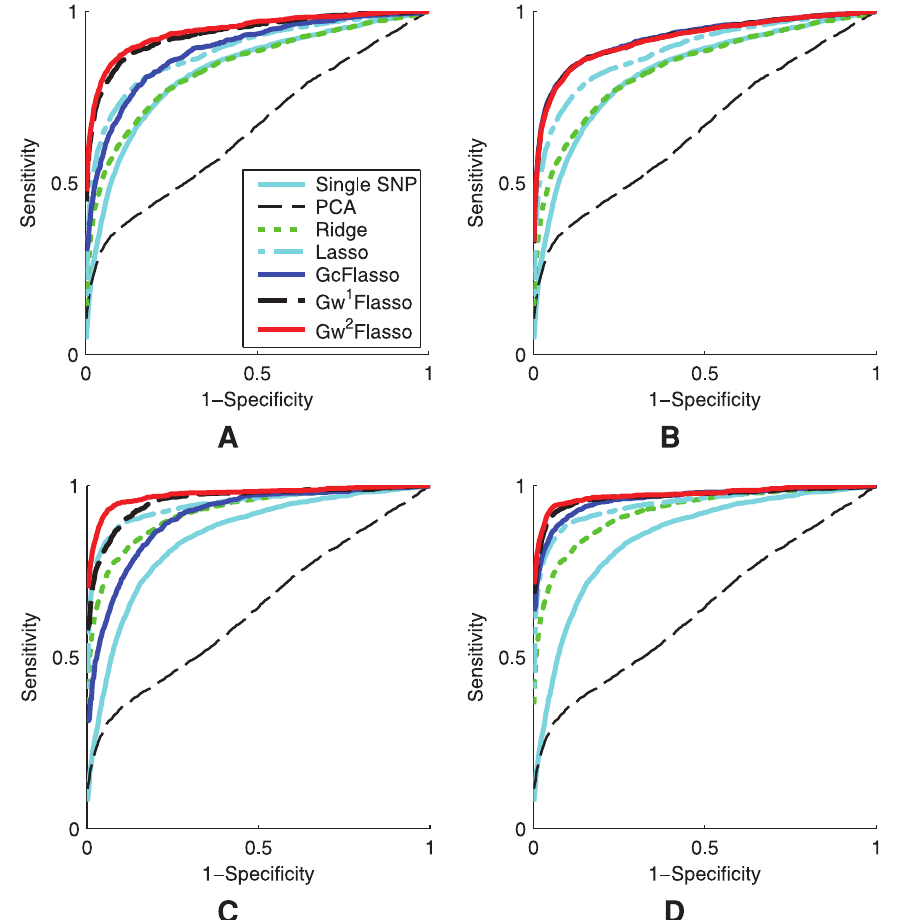
Figure 9. ROC curves comparing association analysis methods. The association strength of a causal SNP is not uniform across correlated phenotypes that the SNP is associated with, and varies within the intervals of [0.3, 0.6] or [0.6, 0.9]. Panels show (A) association strength=[0.3, 0.6] when the threshold r ~ 0 : 1 is used for QTNs, (B) association strength=[0.3, 0.6] when r ~ 0 : 3 , (C) association strength=[0.6, 0.9] when r ~ 0 : 1 , and (D) association strength=[0.6, 0.9] when r ~ 0 : 3 . The sample size was 200. The results were averaged over 50 simulated datasets.